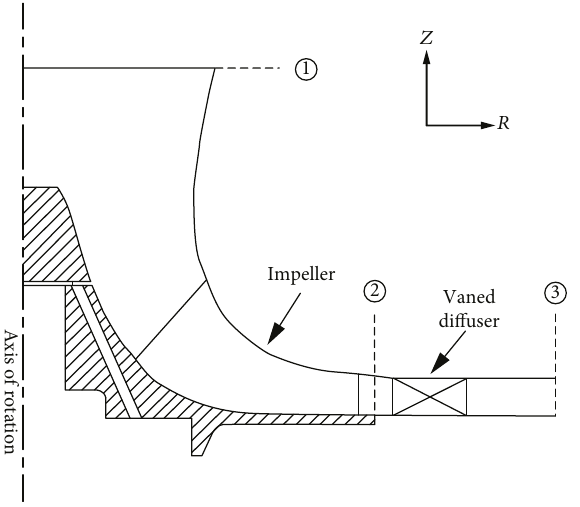
Figure 1: Cross section of the centrifugal compressor stage. Table 1: Speci fi cations of the centrifugal compressor stage.